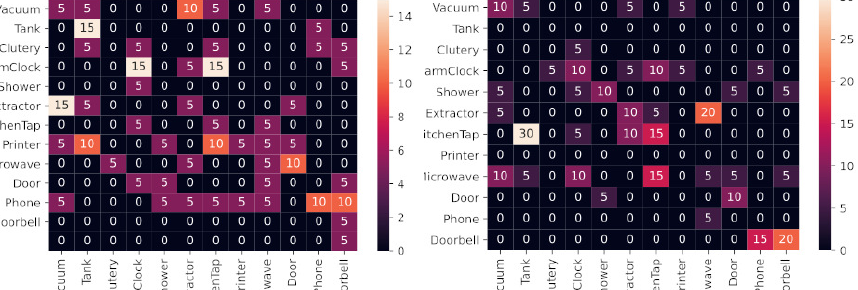
Figure 5. Confusion matrices in Audioset dataset: ( Left ) CNN + MFCC; ( Right ) CNN + LM. Table 3. Classification metrics from offline case study